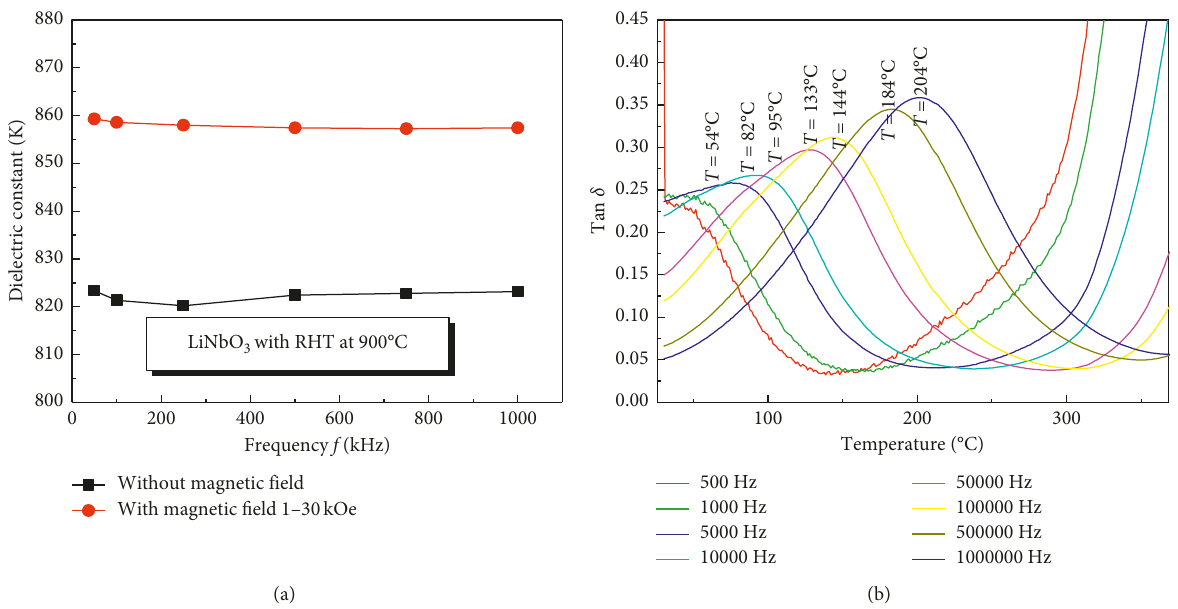
Figure 7: Multiferroic properties: (a) magnetocapacitance response of ferromagnetic LiNbO La 0.05 Li 0.85 NbO 3